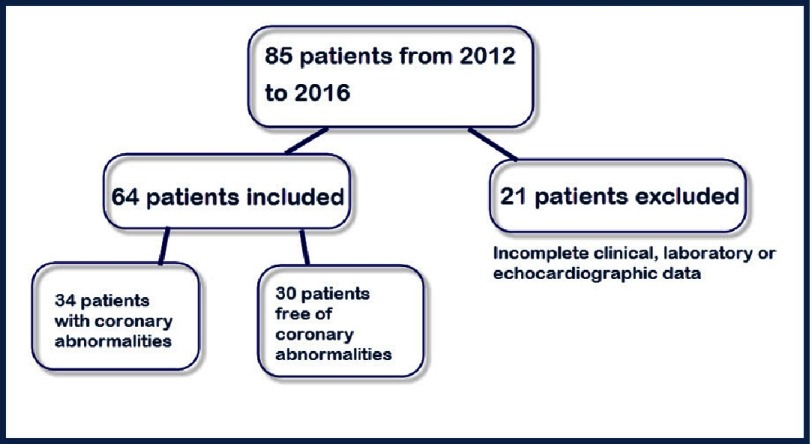
Patient selection.